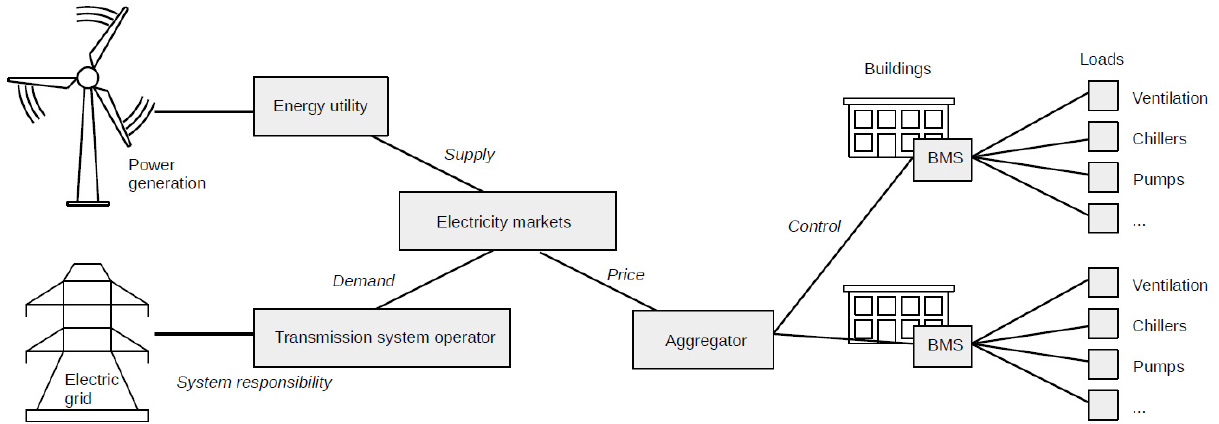
Figure 1. The principle of the interconnection between the electric energy system and the loads involved in demand management. Derived from [11].